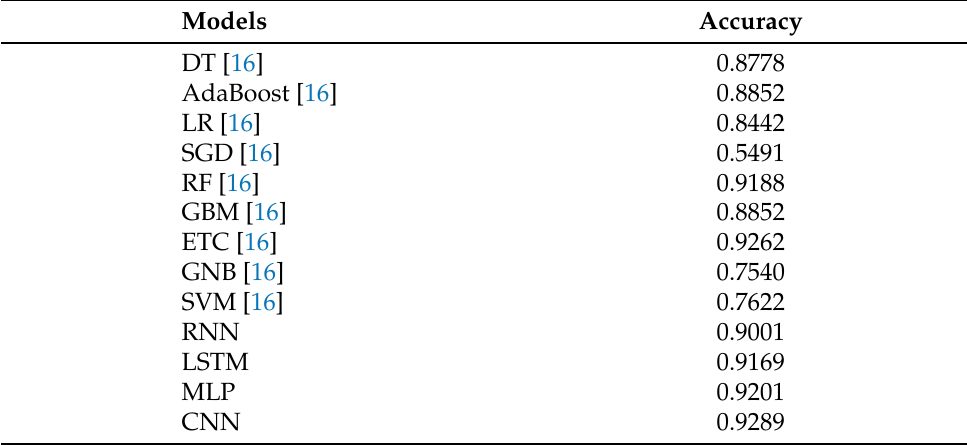
Table 6. Accuracy comparison of deep learning models with machine learning models using signifi- cant features after applying